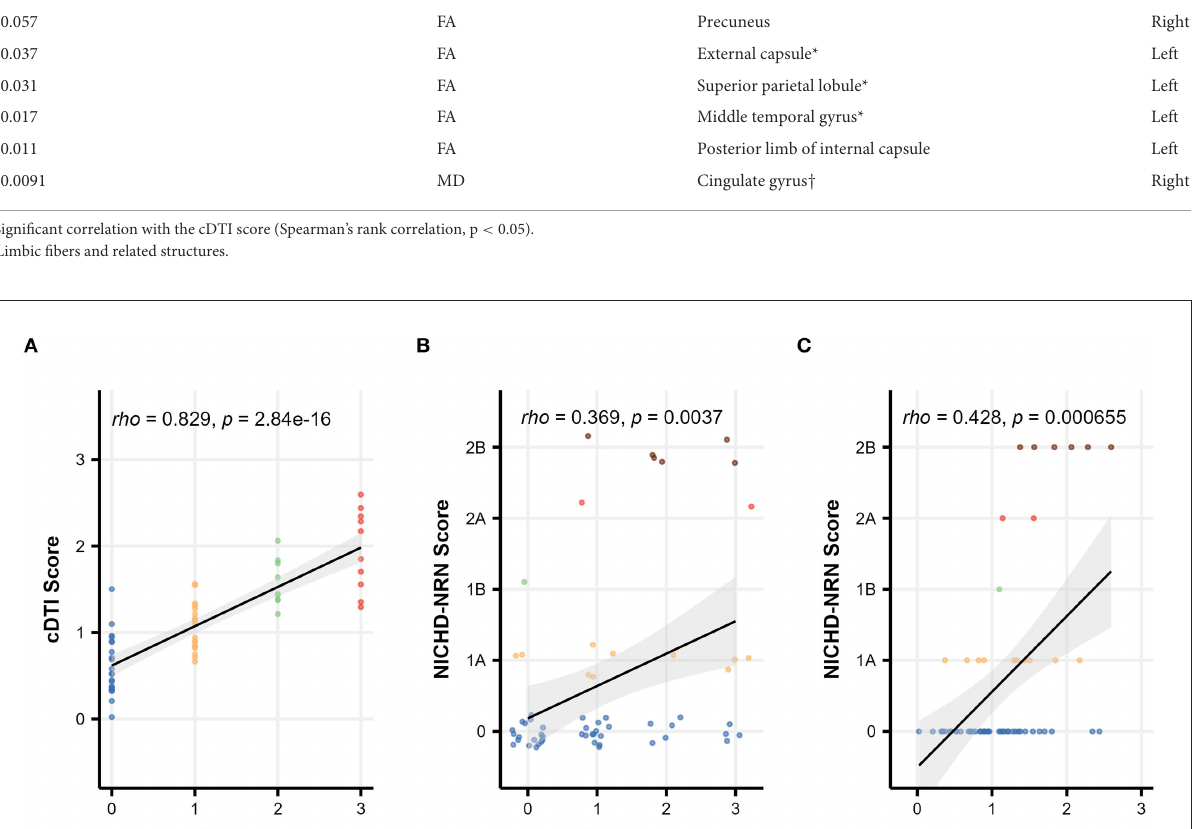
the cDTI mild and severe groups for IL-10 ( p = 4.1 × 10 − 4 ) and tau ( p = 0.014). Significant time effects were present for BDNF ( p = 0.0064), IL-6 ( p = 0.030), VEGF ( p = 6.1 × 10 − 4 ), GFAP ( p